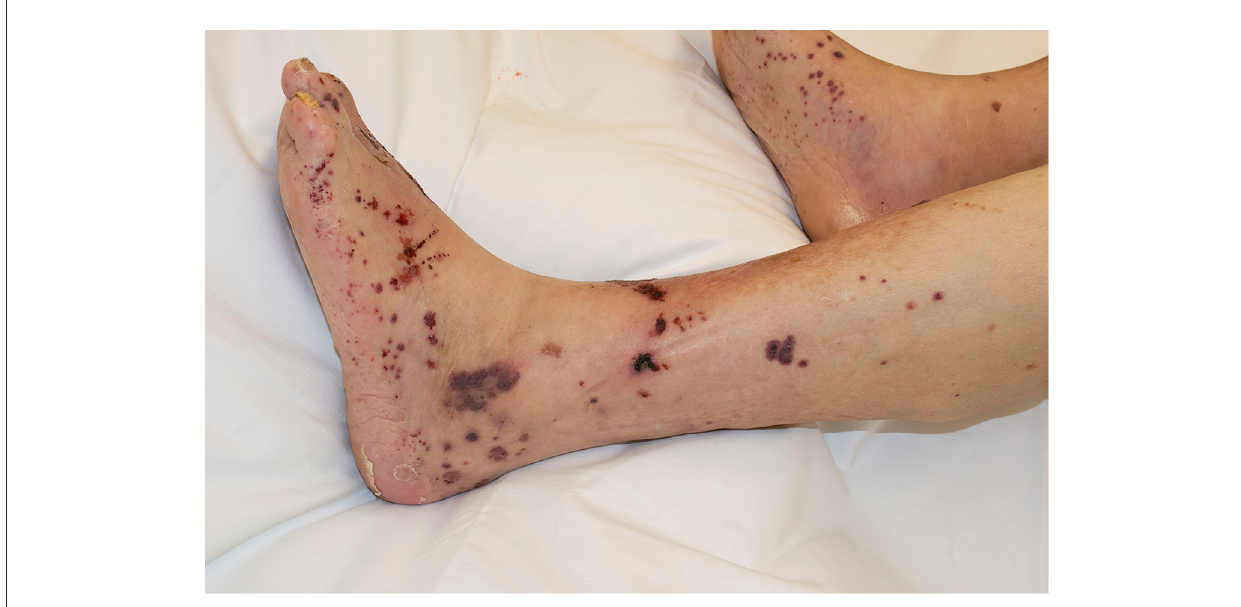
FIGURE1 Round or oval and retiform (or branched) palpable purpura in IgA vasculitis.